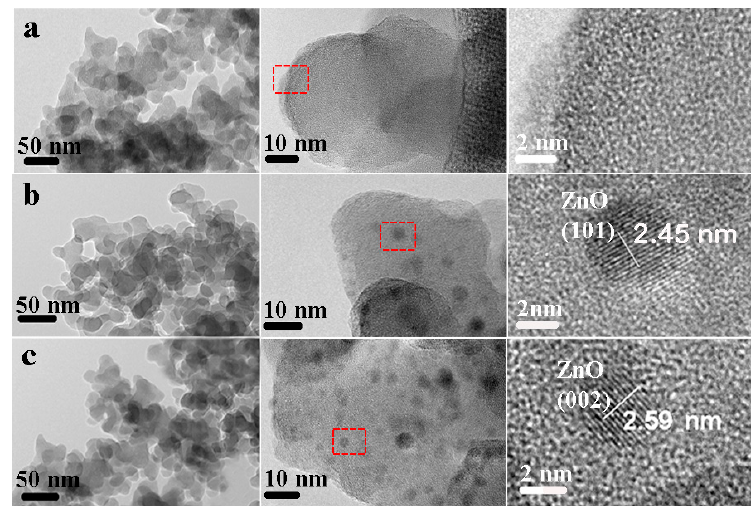
Figure 5. TEM maps of ( a ) amorphous SiO 2 ; ( b ) ZnO–SiO 2 -pH5.0; ( c ) ZnO–SiO 2 -pH7.0 at different scales.